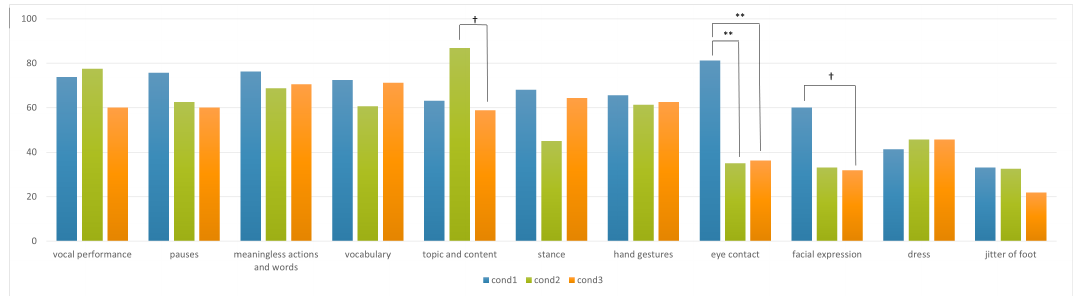
Figure 8. The degree of concern for each part in the playback phase. ∗∗ indicates p < 0.01. † indicates p < 0.1.